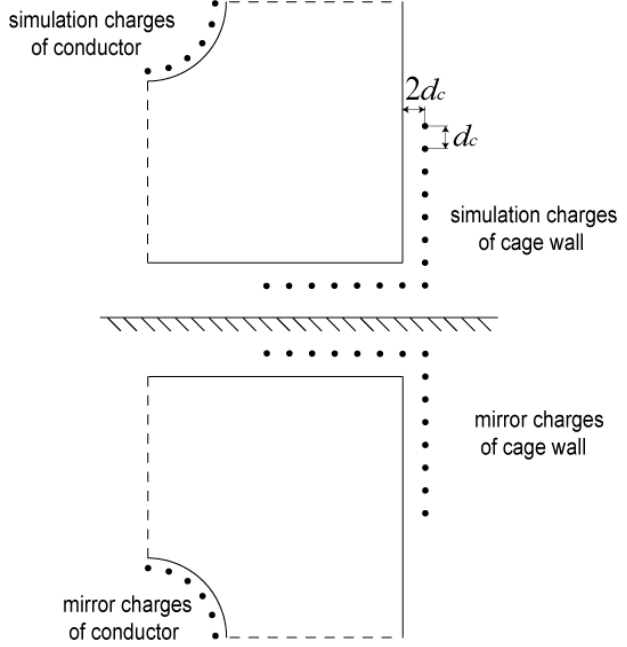
Figure 2. Tessellation of calculation domain.